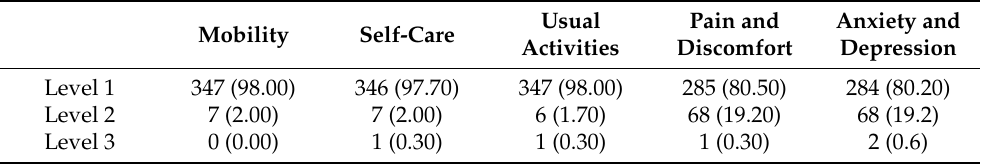
Table 1. EQ5D-3L frequencies by dimension and level (N = 358). Level 1: no problems; level 2: slight problems; level 3: moderate problems. Percentages per level indicated in